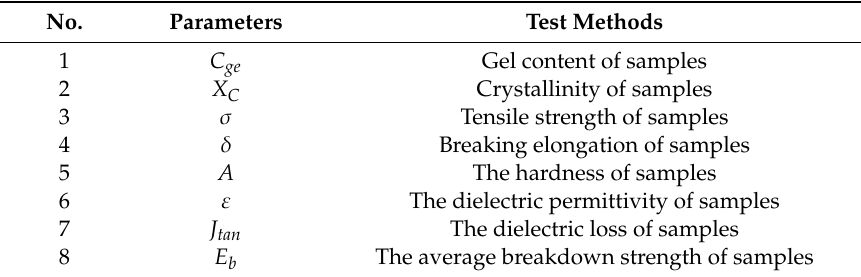
Table 6. Lifespan prediction parameters of